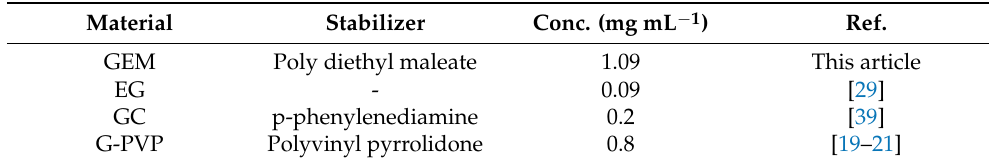
Table 3. Comparison of concentration in ethanol of different graphene-based composites: GEM,